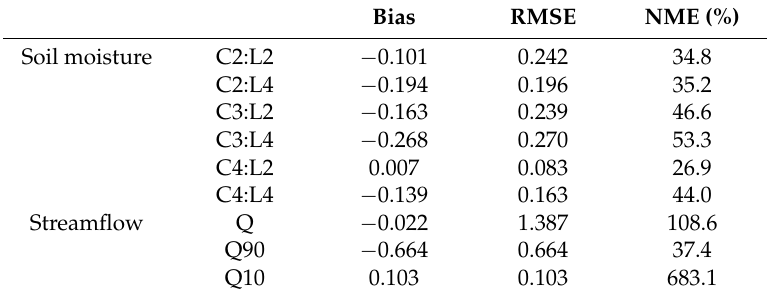
Table 3. Comparison of modelled results to measurements when adopting baseline parameter values. C: soil column; L: layer number. For Bias and RMSE, soil moisture data are in m 3 water m ´ 3 soil and streamflow data in mm.